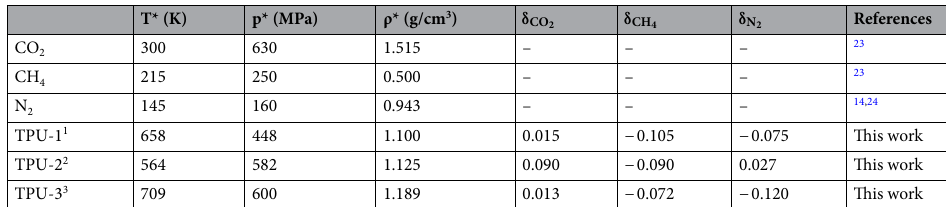
Table 1. The LF characteristic and interaction parameters for all components. 1